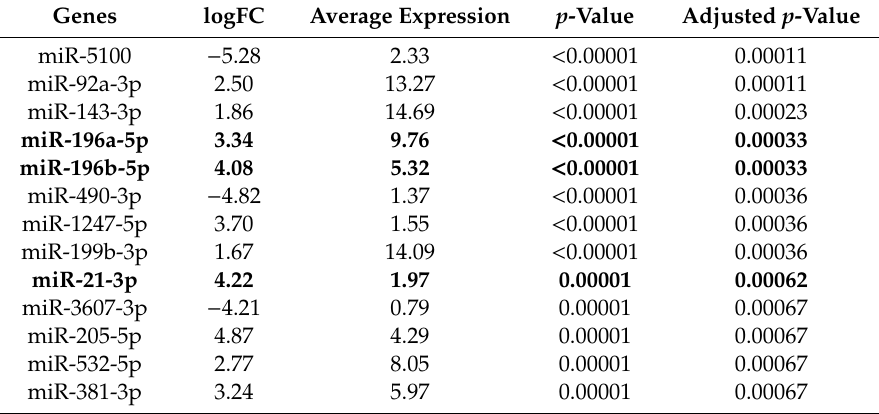
Table 4. MicroRNAs with the most significantly di ff erent levels in cerebrospinal fluid of brain metastases patients in comparison to controls ( p < 0.001) supplemented with additional miRNAs tested in the validation phase of the study listed at the bottom of the table (in italics). All miRNAs selected for the validation phase are in bold; and logFC = binary logarithm of Fold